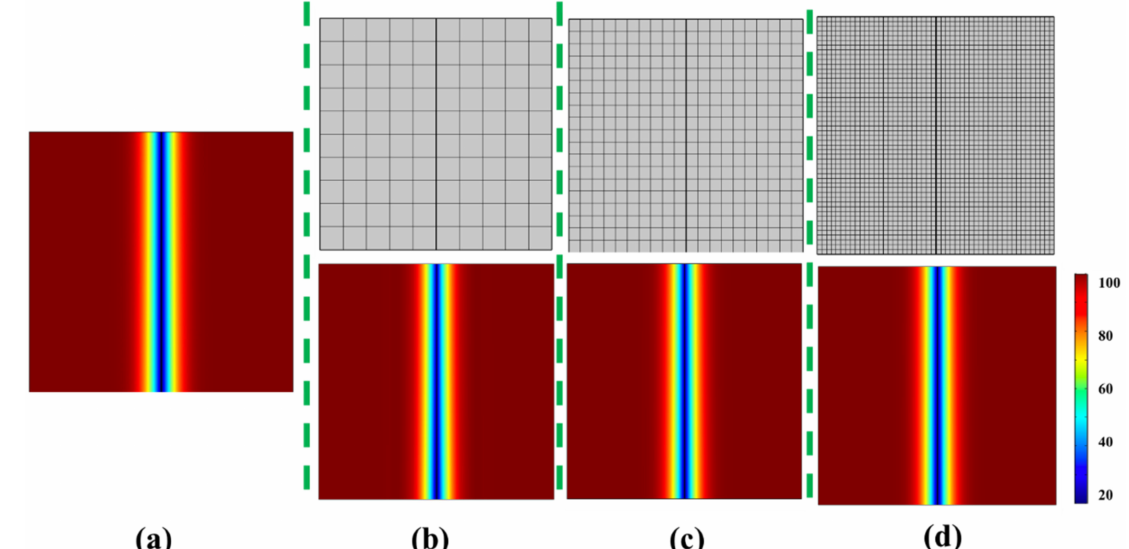
Figure 7. ( a ) Temperature field of analytical solution (after 86,400 s); ( b ) temperature field of COMSOL solution (after 86,400 s and grid size = 1 m); ( c ) temperature field of COMSOL solution (after 86,400 s and grid size = 0.5 m); and ( d ) temperature field of COMSOL solution (after 86,400 s and grid size = 0.2 m).